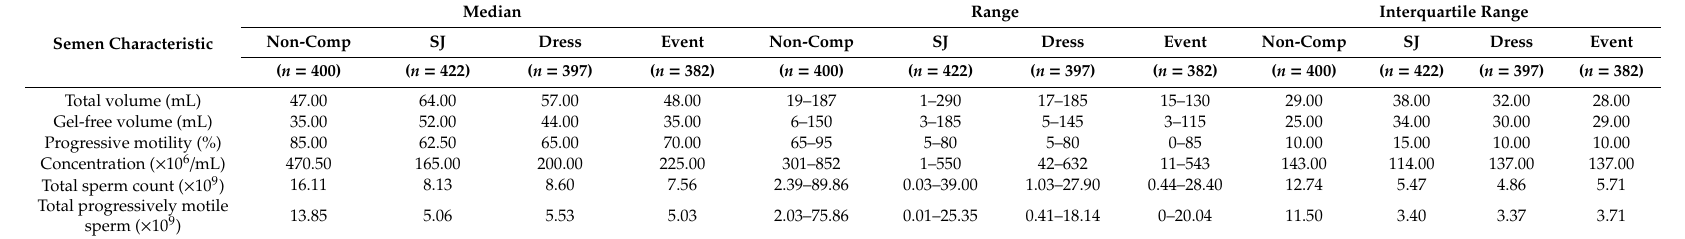
Table 3. Medians, ranges and interquartile ranges for each semen characteristic among varying stallion